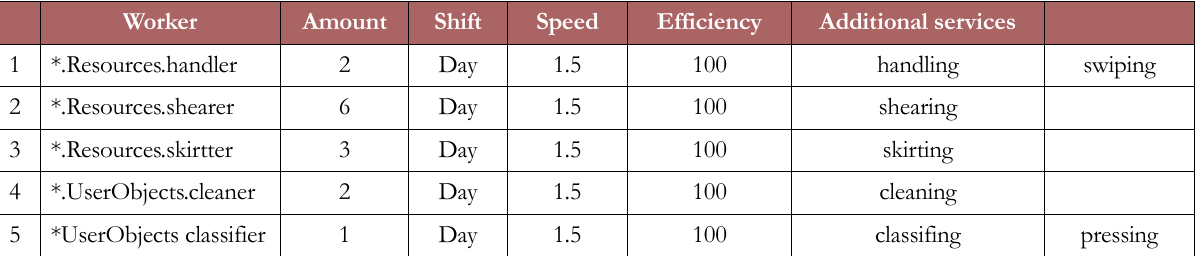
Table 1. Workers’ parameters for both layouts in Plant